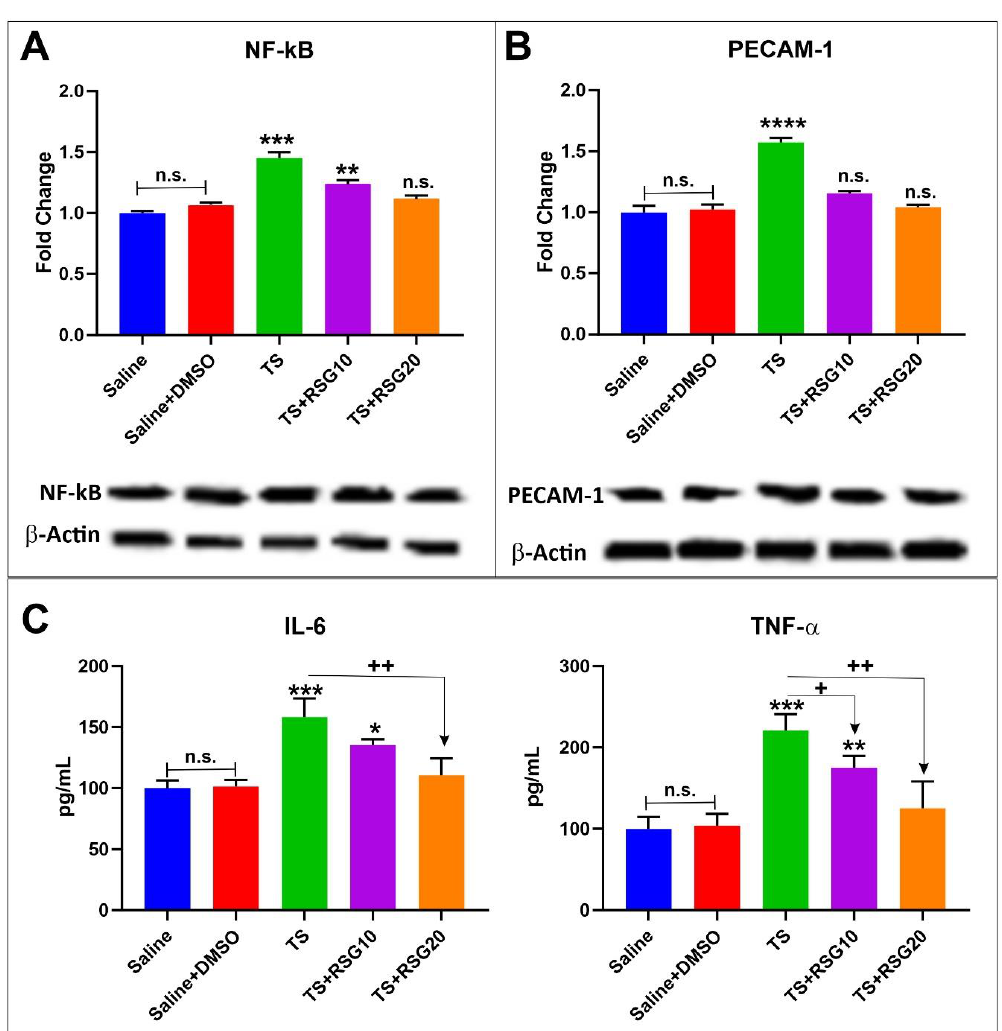
Figure 5. RSG decreases intracellular inflammation induced by TS. ( A ) Expression level of the inflammatory marker NF-kB, which was increased in cells treated with TS, but was downregulated by RSG. ( B ) Expression level of the inflammatory marker PECAM-1, which was increased in cells treated with TS, was downregulated by RSG. ( C ) ELISA of pro-inflammatory cytokines TNF- α and IL-6. RSG reduced TS induced TNF- α and IL-6 release. n = 4 biological replicates; * p < 0.05, ** p < 0.01, *** p < 0.001, and **** p < 0.0001 versus saline. + p < 0.05, ++ p < 0.01 versus TS. WB analyses report protein / β -actin